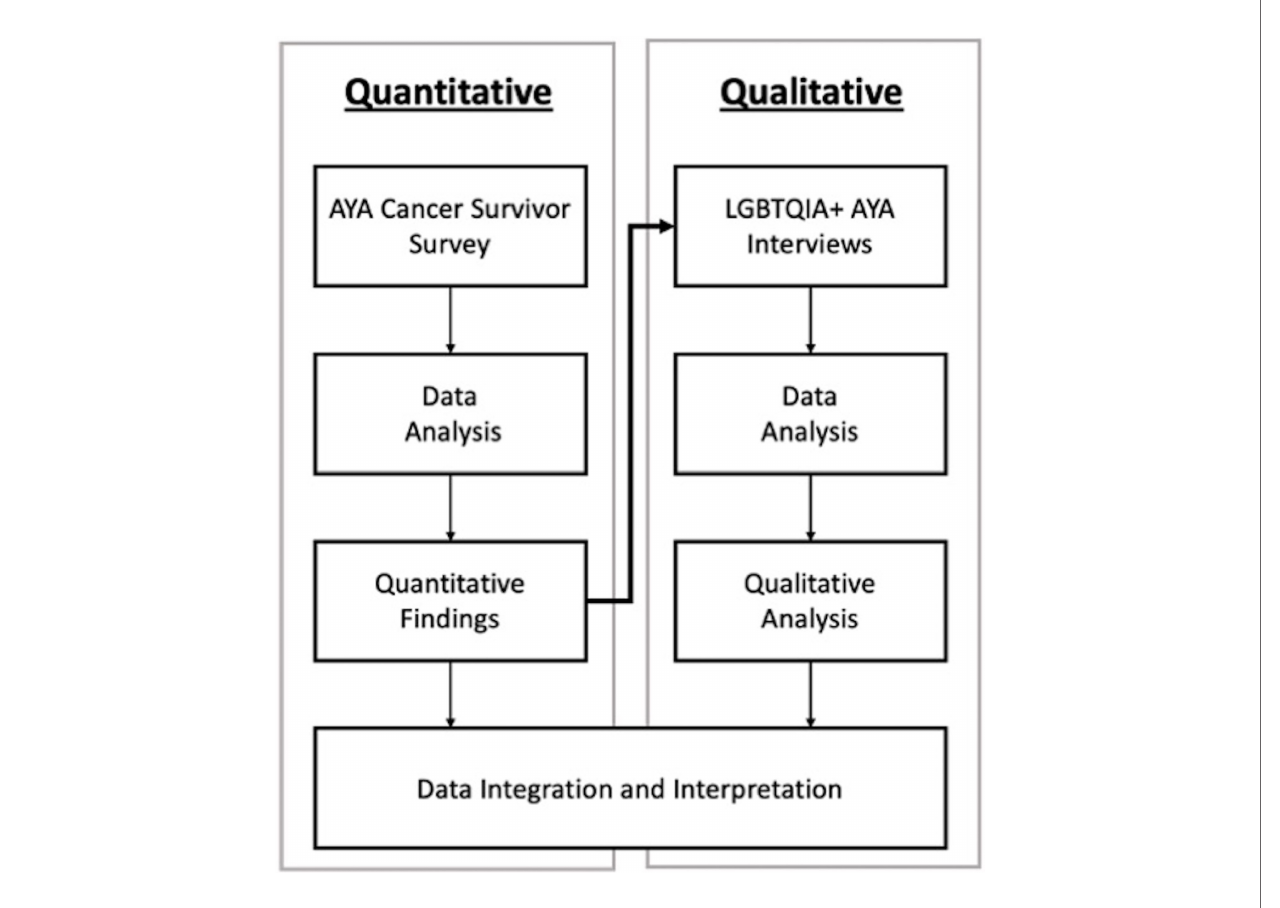
FIGURE 1 | Explanatory Sequential Mixed Methods Study Design